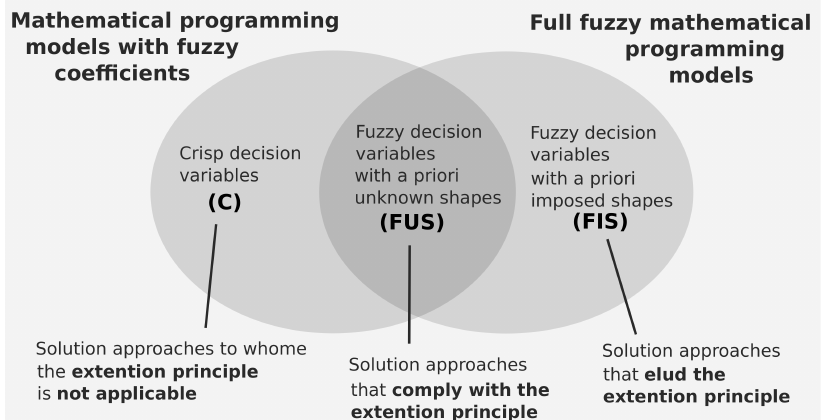
Figure 1. Decision variables shapes with respect to the two types of fuzzy mathematical program- ming and how they comply with the extension principle.